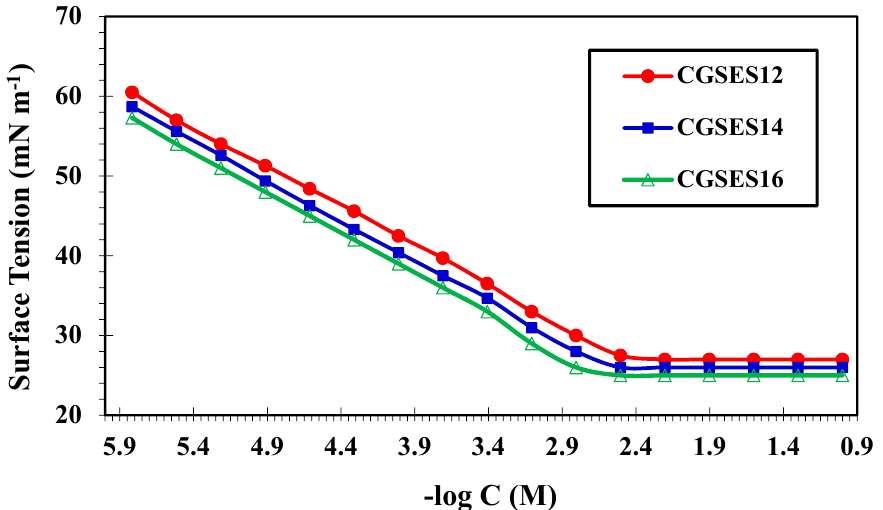
Table 9. Surface tension parameters of the synthesized cationic gemini surfactants in double-distilled water at 25 °C.